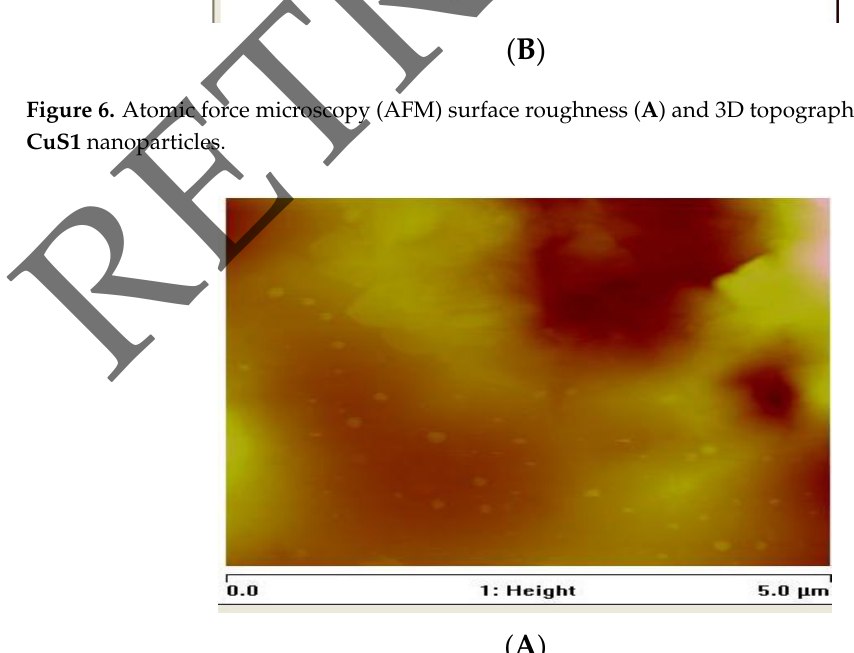
Figure 6. Atomic force microscopy (AFM) surface roughness ( A ) and 3D topographical images ( B ) of CuS1 nanoparticles.